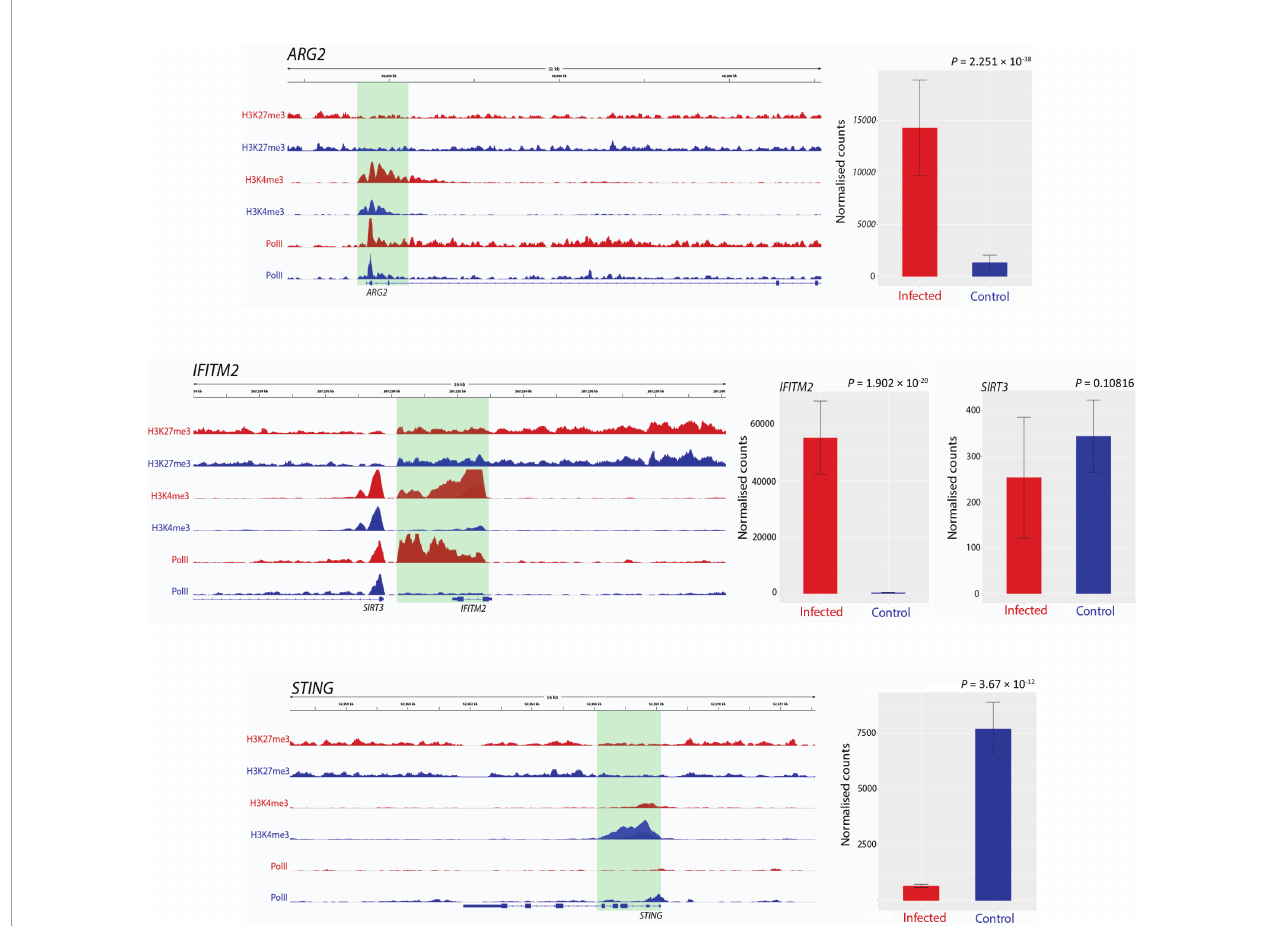
FIGURE 1 | Track visualization of M. bovis induced H3K4me3 and Pol II occupancy with relative change in expression at three immune response associated genes. Examples of signal tracks illustrating peaks of H3K27me3 (top two tracks), H3K4me3 (middle two tracks) and Pol II (bottom two tracks) in infected (red) and non- infected (blue) bovine alveolar macrophages, with the bovine reference genome on the bottom of each panel reading left to right. Accompanying each track image is the expression of the corresponding gene, with normalised counts of infected cells in red and control in blue. The ARG2 gene exhibited an increase in H3K4me3 at 24 hpi as evidenced by the larger red H3K4me3 and red Pol II peaks. The IFITM2 gene also exhibited larger H3K4me3 and Pol II peaks in infected samples; however, in contrast to this, SIRT3 , which is located ~20 kb upstream from IFITM2 gene, had no signi fi cant change in either peak. TMEM173 (aka STING ) exhibits an opposite pattern to most genes identi fi ed as having differential H3K4me3, where a larger peak is observed in control samples rather than